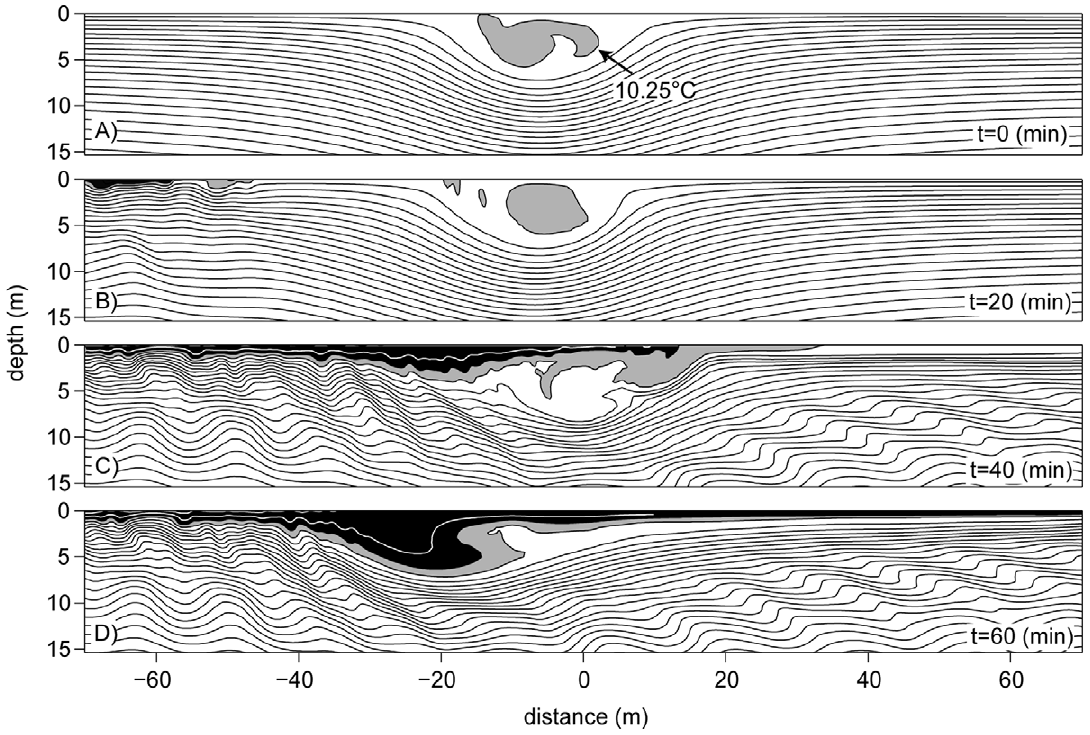
Figure 7. A simulated breaking limited wave encountering a perturbation. Dynamical simulations of (A) a wave with a quasi-steady core and (B–D) a perturbation of the wave in (A), 20, 40 and 60 min after a disturbance (a patch of light (black) fluid in the top 2.4 meters of the water column) was introduced upstream of the wave. Isotherms are given in 0.25 u C intervals.